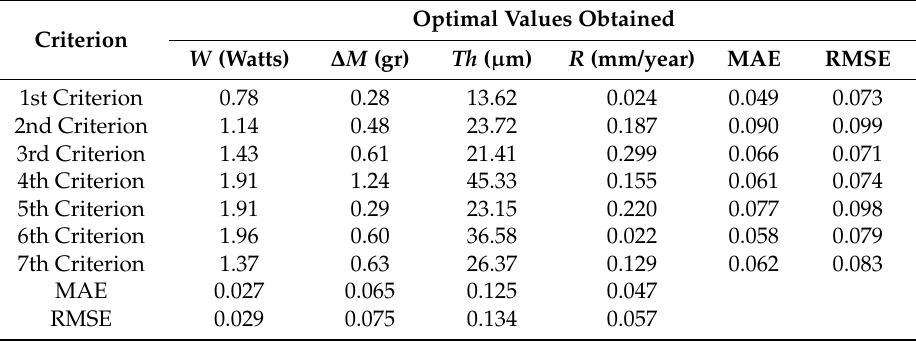
Outputs or zinc coating parameters attained when the five design requirements were